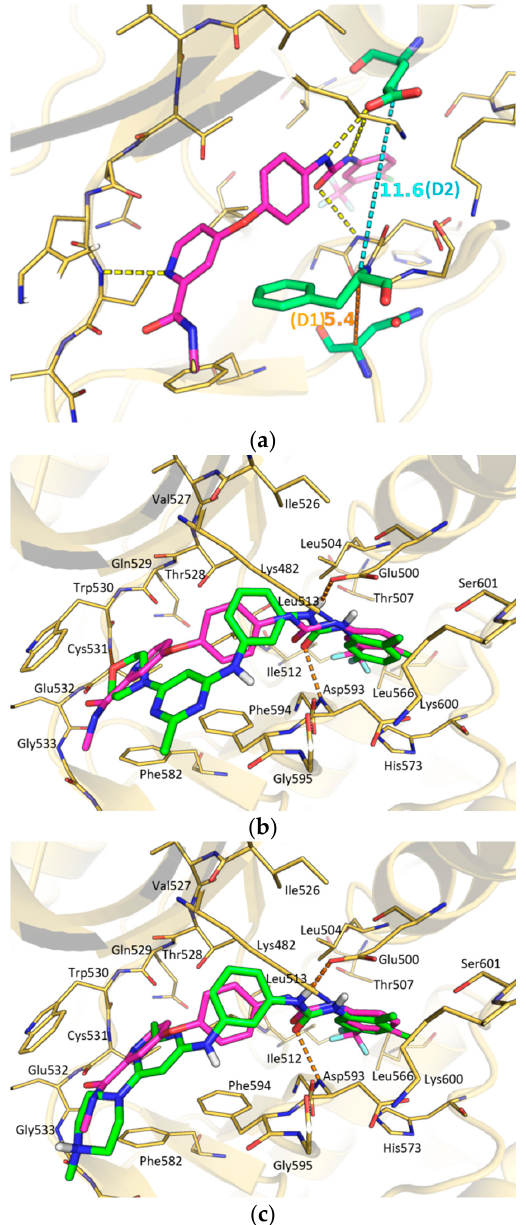
Figure 6. ( a ) The distance criteria D1 (5.4 Å) and D2 (11.6 Å) confirmed that sorafenib binds to the classical DFG-out conformation of BRAF-V600E (PDB code 1UWJ). Docking of ( b ) SI-046 and ( c ) SI-098 in the crystal structure of sorafenib bound to the classical DFG-out conformation of BRAF-V600E (PDB code 1UWJ). Sorafenib is colored magenta. SI-046 and SI-098 are colored green. H-bonds are depicted as orange dashed lines. Key interacting residues are illustrated in golden sticks.